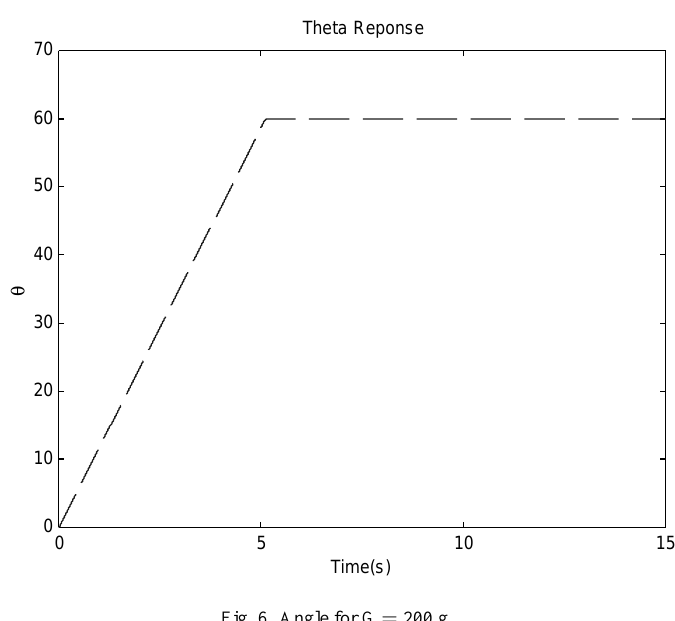
Fig. 6. Angle for G = 200